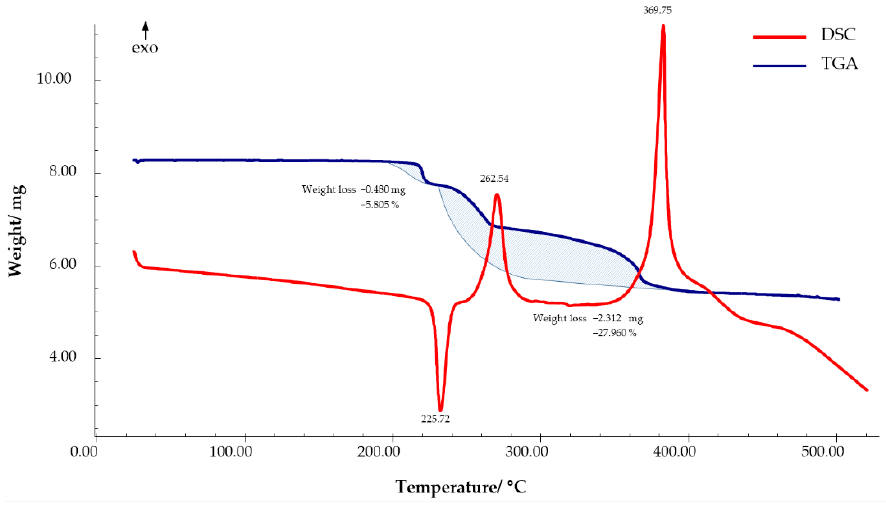
Figure 8. Thermal analyses (thermogravimetry with insert of differential scanning calorimetry) of [Cd(NO 3 )(pfb)(phen)] n ( 2 ). Blue—TGA curve, Red—DSC curve.